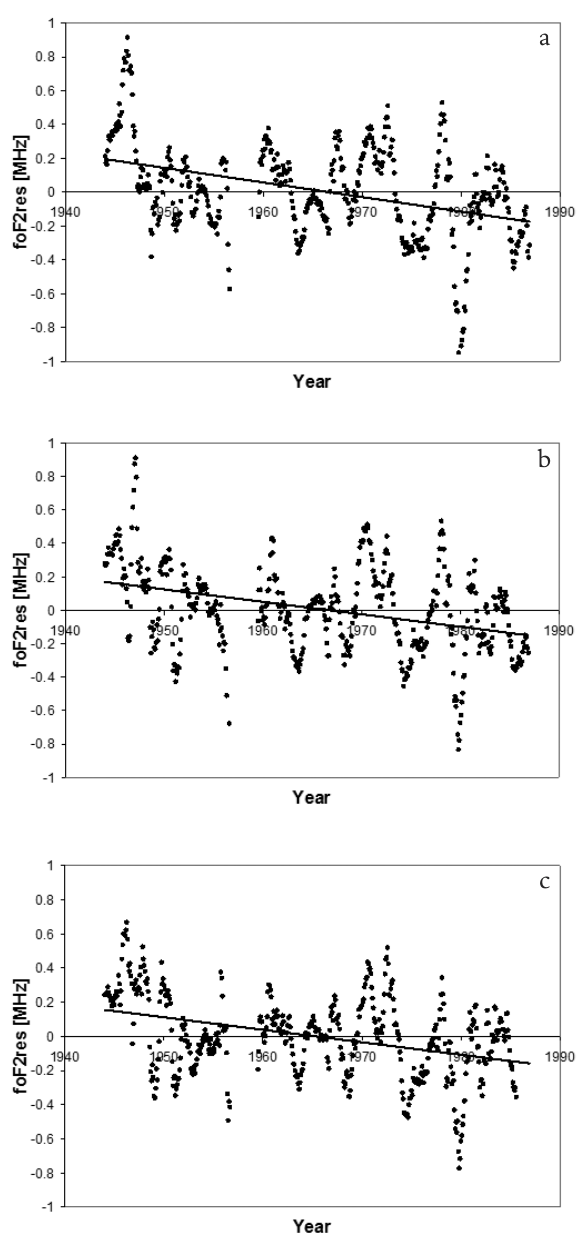
Figure 1. foF2 residual for (a) Brisbaen (27.5°S, 152.9°E), (b) Can- berra (35.3°S, 149.0°E) and (c) Christchurch (43.6°S, 172.8°E), after filtering seasonal and solar activity effects using Rz as solar EUV proxy (black dots) and fitted linear trend (solid line).